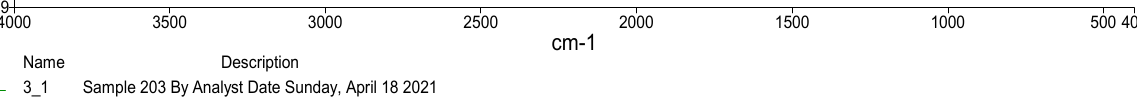
Figure 7. FTIR spectrum of silver nanoparticles formulated using S. officinalis extract. Table 1. Functional groups of the biogenic AgNPs detected using FTIR analysis .